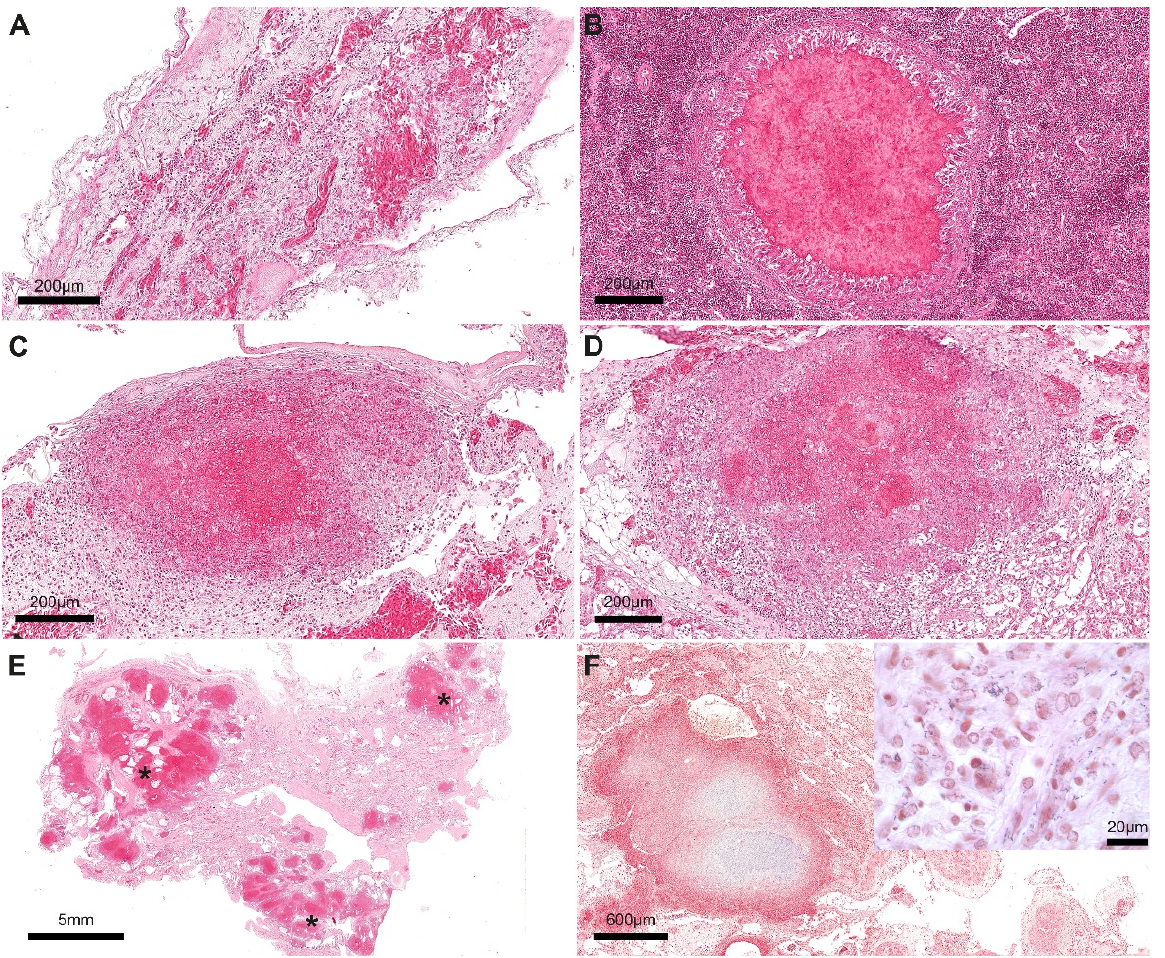
Figure 2. Yellow foci of necrosis in kidneys ( A ), spleen ( B ), and cardiac tissue ( C ).